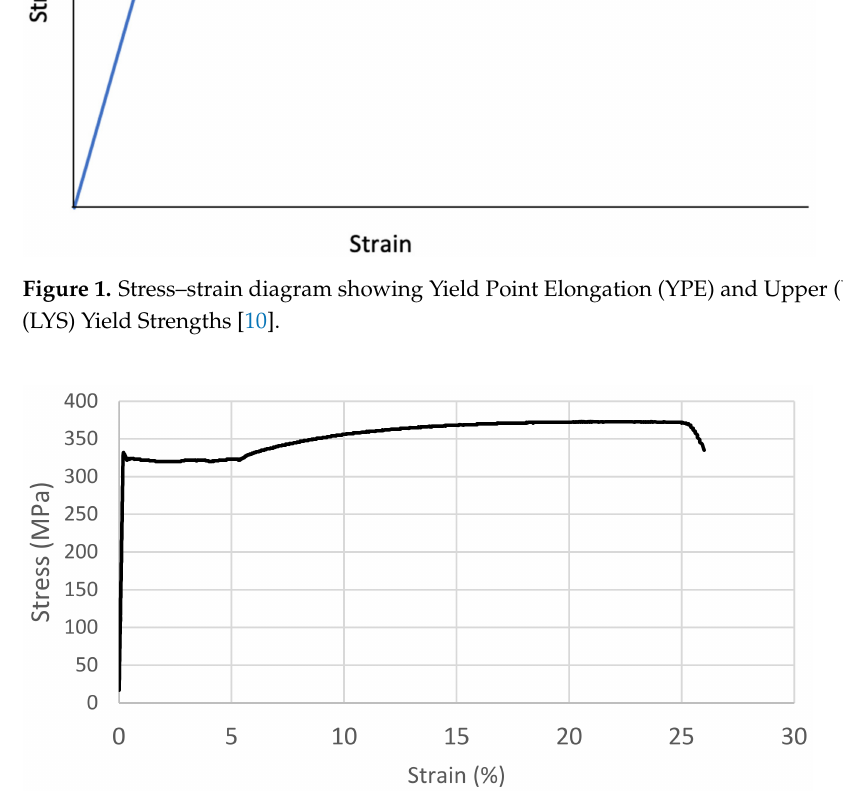
Figure 2. Typical stress–strain curve for plain steel subjected to tensile